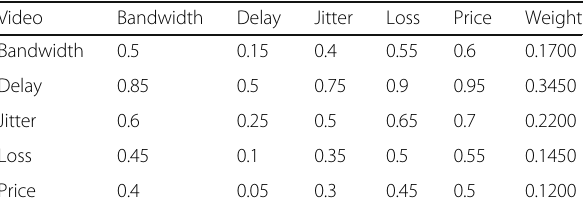
Table 10 Applications and network attributes relationship matrix